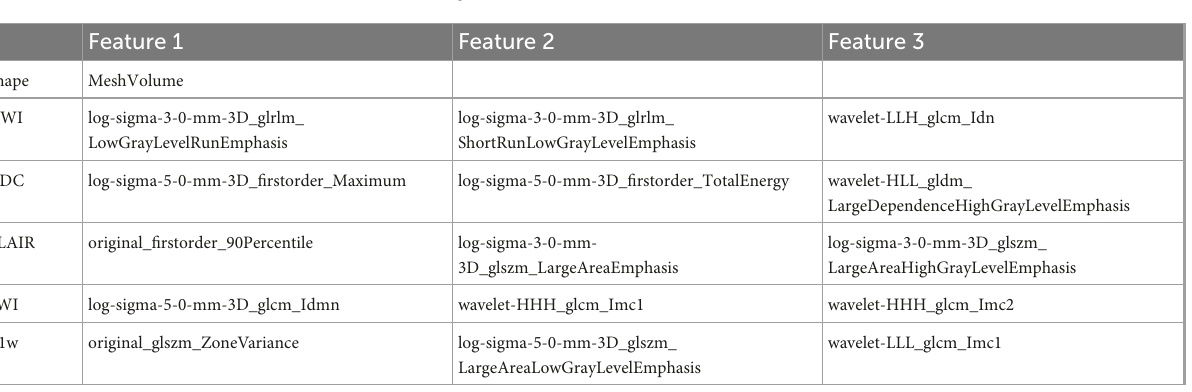
TABLE 2 Results of feature selection for each MRI